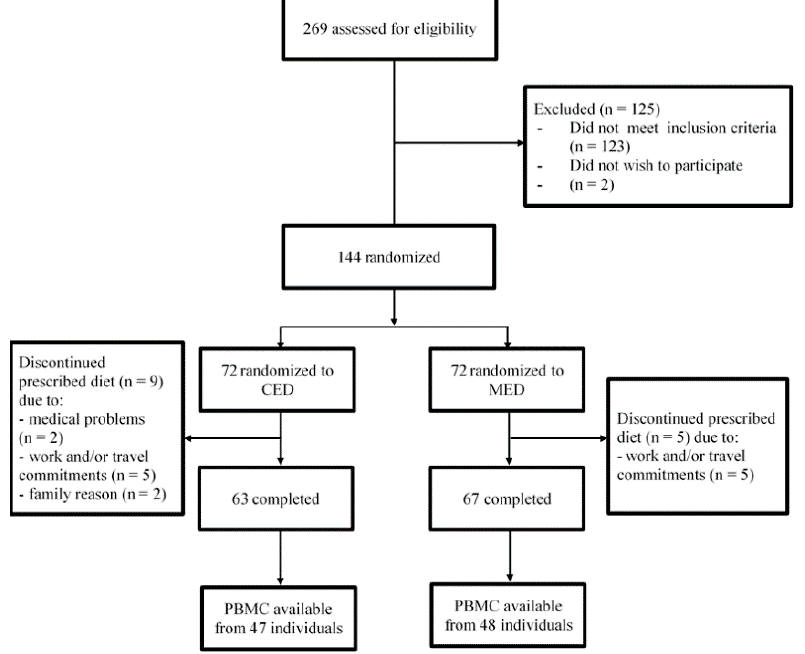
Figure 1. Flow diagram.